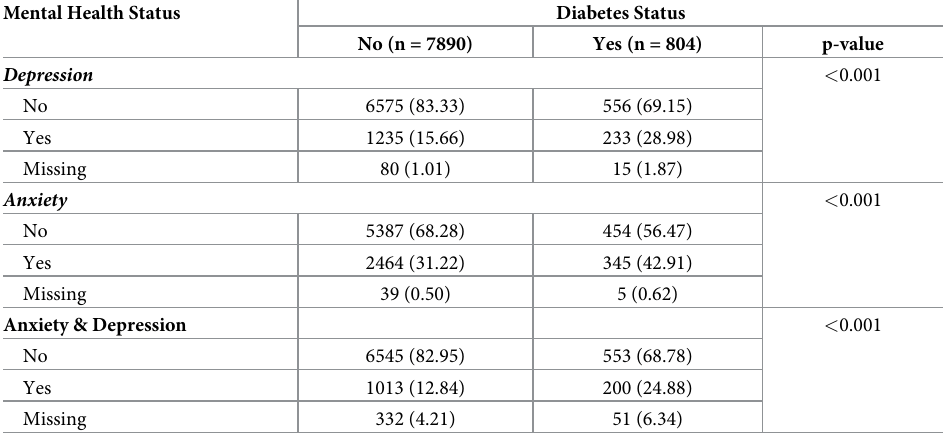
Table 1. Associations between mental health status and diabetes mellitus for 8694 participants in survey 7